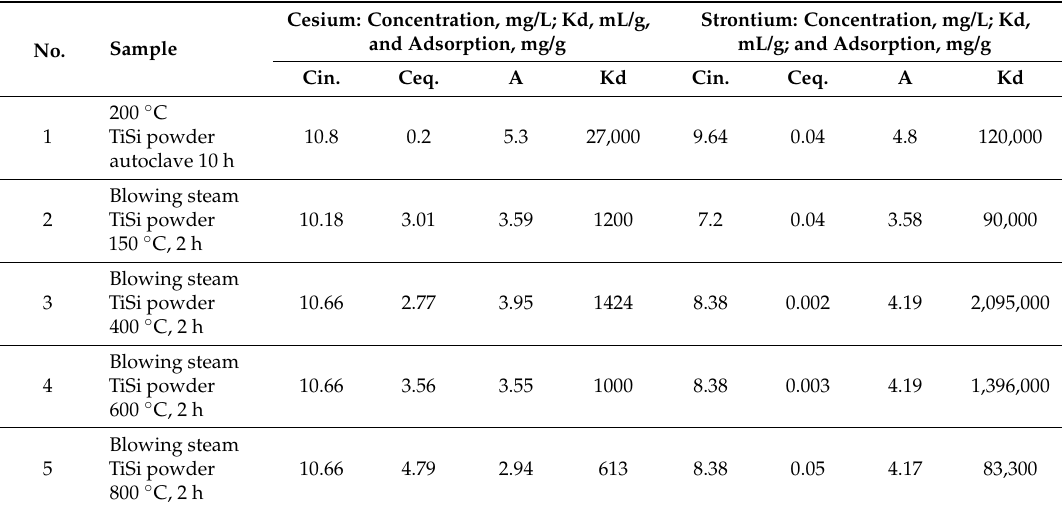
Figure 8. Cesium adsorption isotherms from the background 0.01M NaCl solution by sample 7. □ —TiSi-powder fraction; ◊—Carbon-TiSi fraction; at low concentrations ( A ); at middle concentrations ( B ). Table 3. Adsorption properties of the samples TiSi-powder fraction prepared by various hydrothermal treatment.